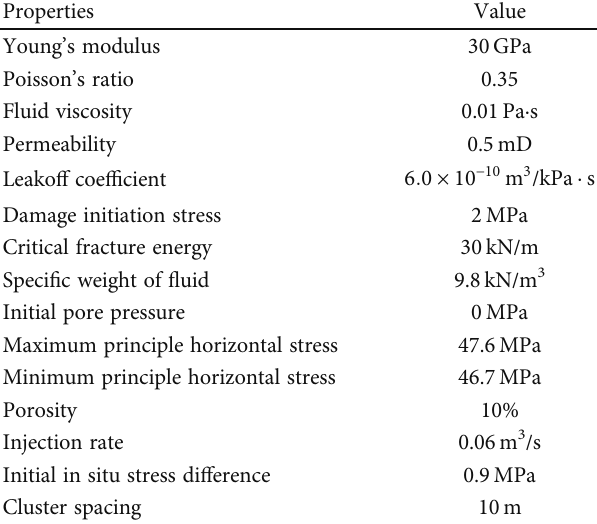
Table 1: Parameters entered to verify model